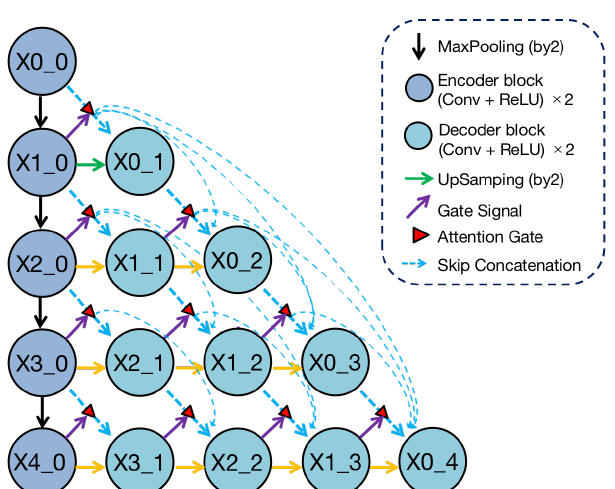
Figure 2. Structure of Render U-Net. Every convolutional block captures features through two convolutional layers, which are activated by ReLU functions. From a horizontal perspective, all blocks are connected by dense skip connections with attention gates. Each block in the decoders concatenates multi-scale features from its all preceding blocks. Each block in the encoder transfers features from top to bottom through the maxpooling method from a vertical perspective, and each block in the decoder integrates multi-scale features across different resolutions through the point-sampling method. In addition, the block in deeper layer is sent to the attention gate as a gate signal.